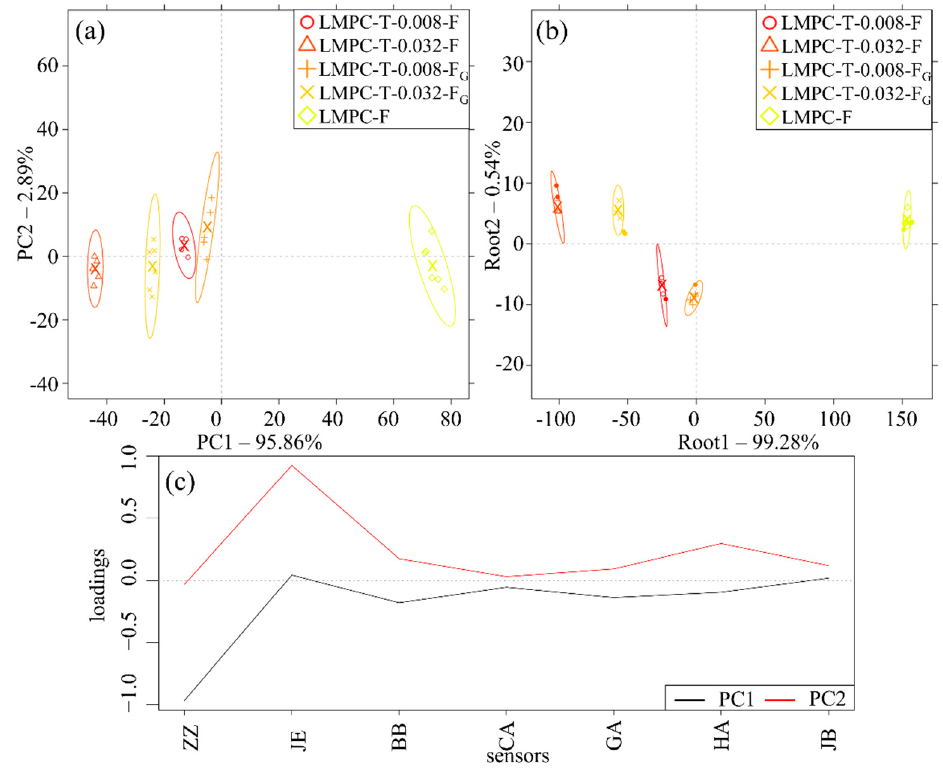
Figure 1. PCA score plot ( a ), LDA score plot ( b ) and PCA loading plots ( c ), which were developed based on the results of the E-tongue with aqueous solutions of LMPC-T-0.008-F, LMPC-T-0.032-F, LMPC-T-0.008-F G , LMPC-T-0.032-F G and LMPC-F (ellipses show the 95% confidence interval, filled dots on the LDA figure represent the observations used in the cross-validation). LMPC: liquid milk protein concentrate, T: trypsin, F: fermentation with lactic acid bacteria in absence of glucose, F G : fermentation with lactic acid bacteria in presence of glucose.